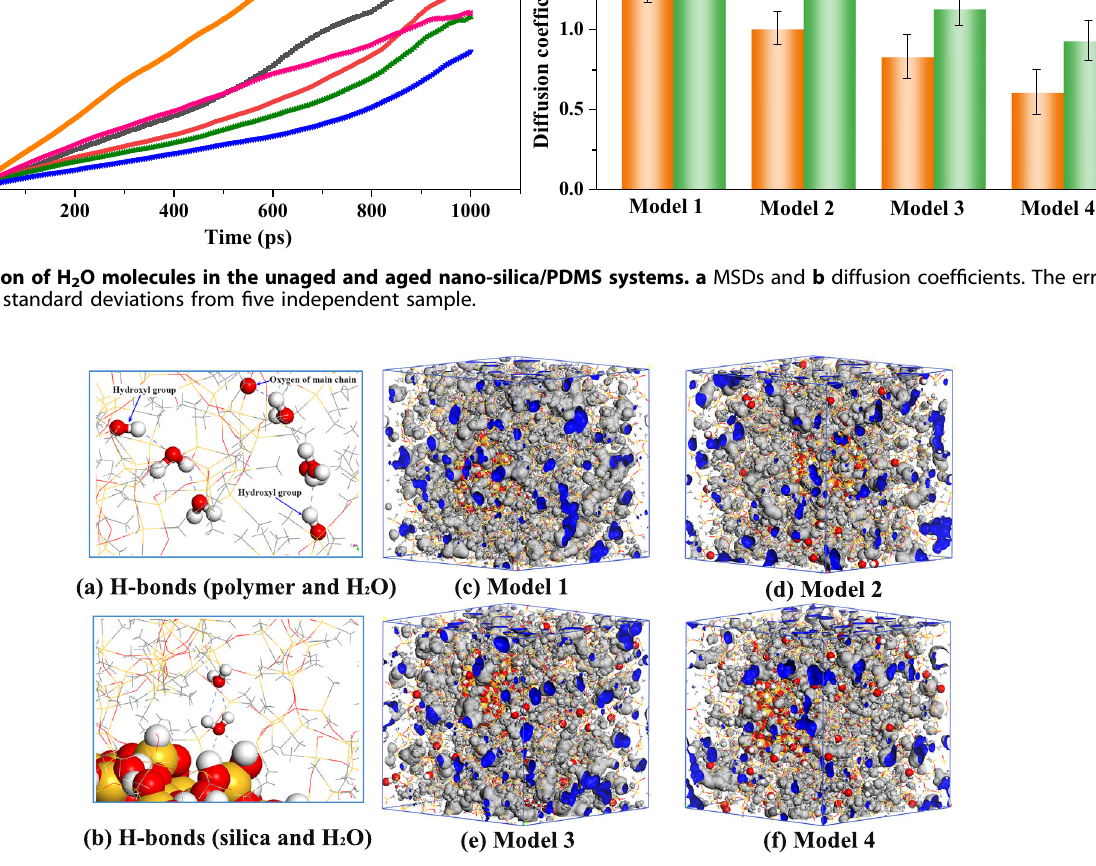
Fig. 10 The H-bonds and accessible volume for H 2 O molecules in the unaged and aged nano-silica/PDMS systems. a H-bonds between the polymer chains and H 2 O, b H-bonds between the silica and H 2 O, c accessible volume in Model 1, d accessible volume in Model 2, e accessible volume in Model 3, and f accessible volume in Model 4.